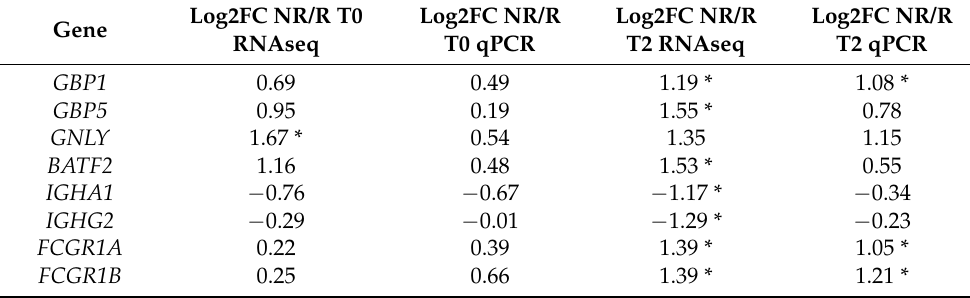
Table 5. Correlation between RNAseq and qRT-PCR for selected